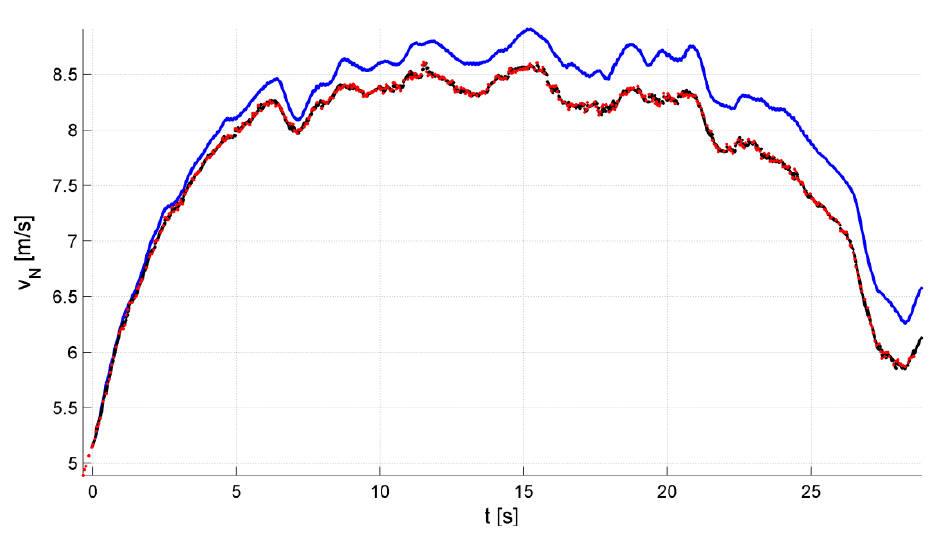
Figure 5. Velocity along north axis: black—INS/GPS, red—GPS, blue—INS.